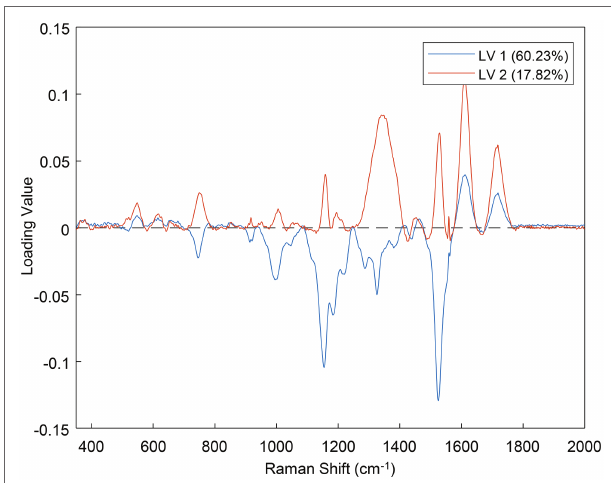
FIGURE 9 | Loadings plot for the first two latent variables (LVs) of the best performing PLS-DA